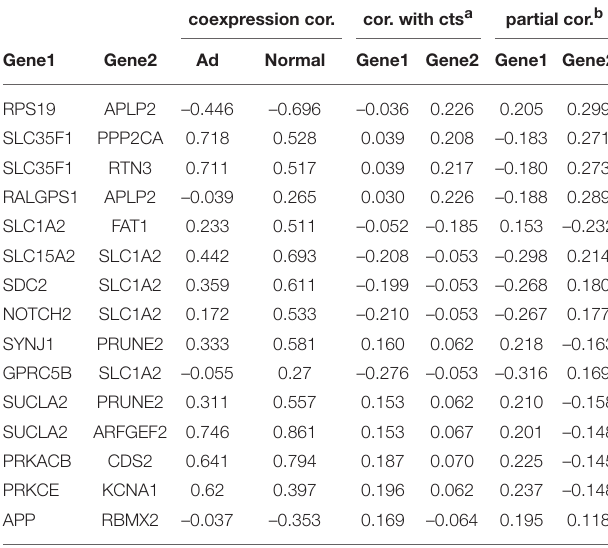
TABLE 2 | The association of dysregulated genes with the cognitive test scores. coexpression